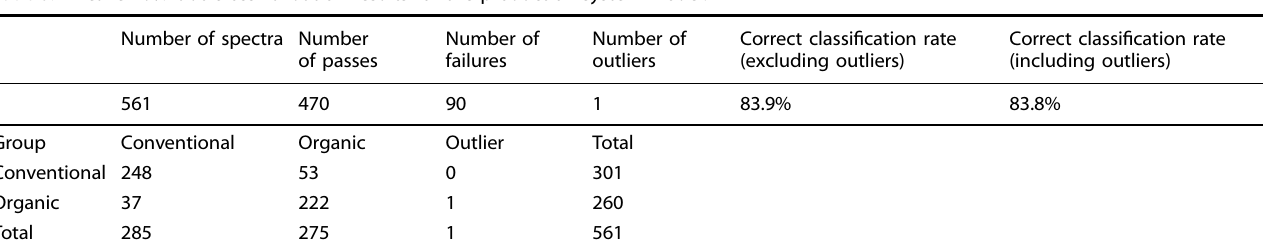
Fig. 3 Production system models. a PCA plot for the production system model, with weak evidence of grouping by the organic and conventional groups. b PCA-LDA plot for the production system model, again with weak evidence of grouping by the organic and conventional groups and no clear separation between the two groups. Table 3. Leave-20%-Out cross-validation results for the production system